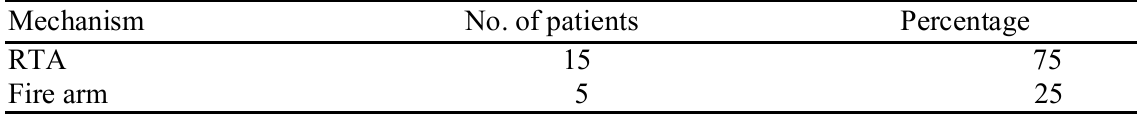
Table 2: Mechanism of injury (n=20)